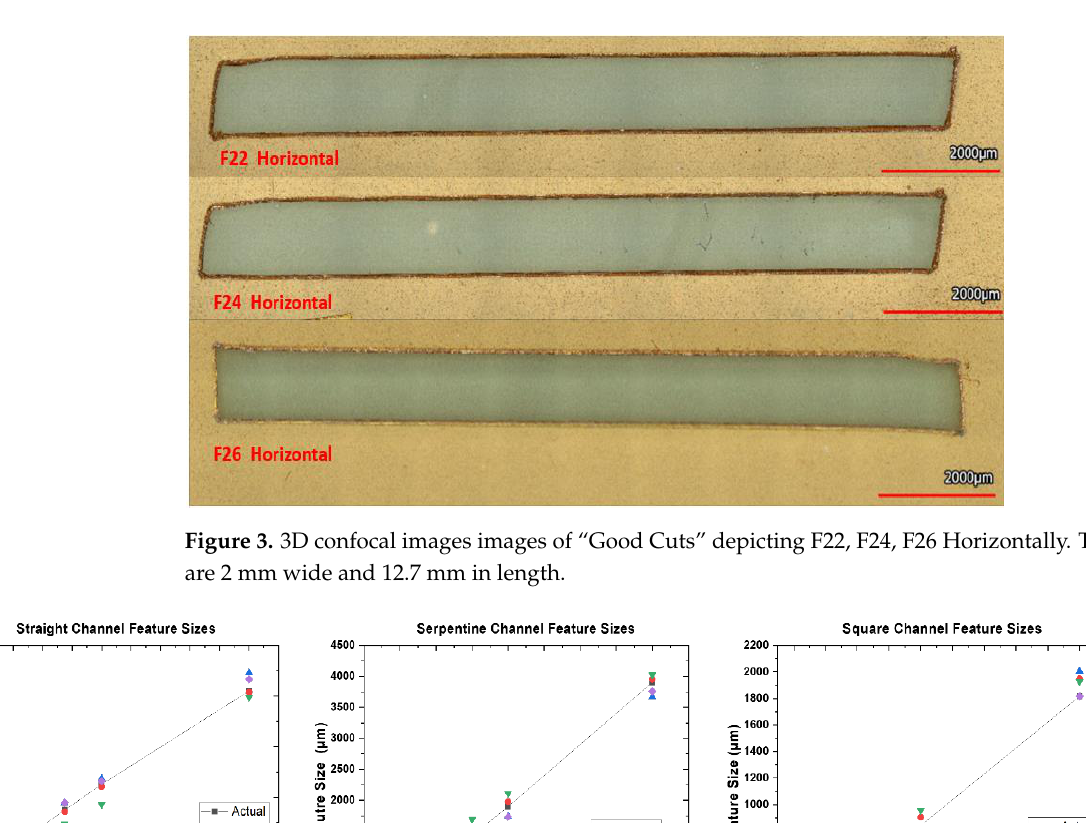
Table 1. Characterization of Forces for Cutting Kapton.